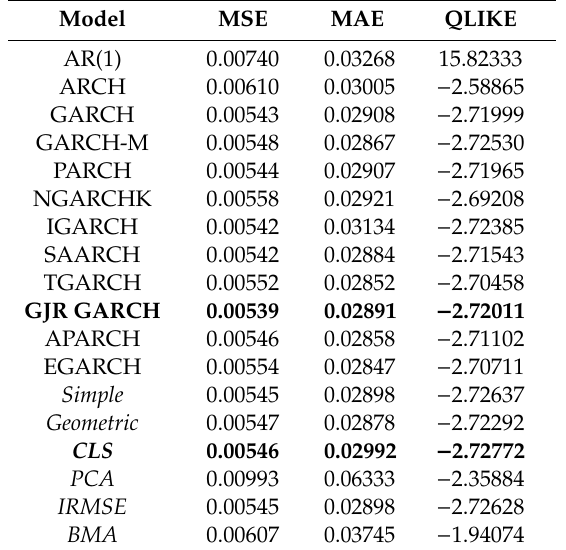
Table 5. Electricity log returns forecast loss functions. Best performing models / combinations in bold. Combinations in italics.